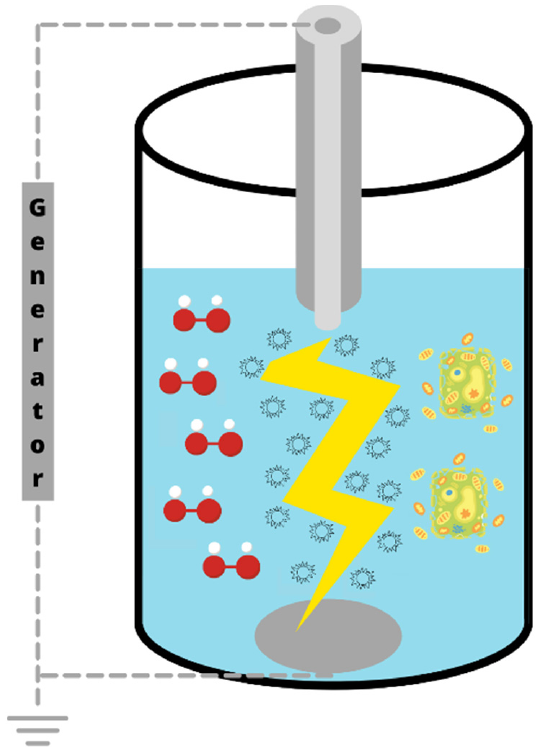
Figure 7. Mechanisms involved in the HVED process, enabling the cell disintegration and the release of target compounds: hydroxyl radical generation, electrical breakdown, collapse of cavitation bubbles, shock waves, and turbulence.